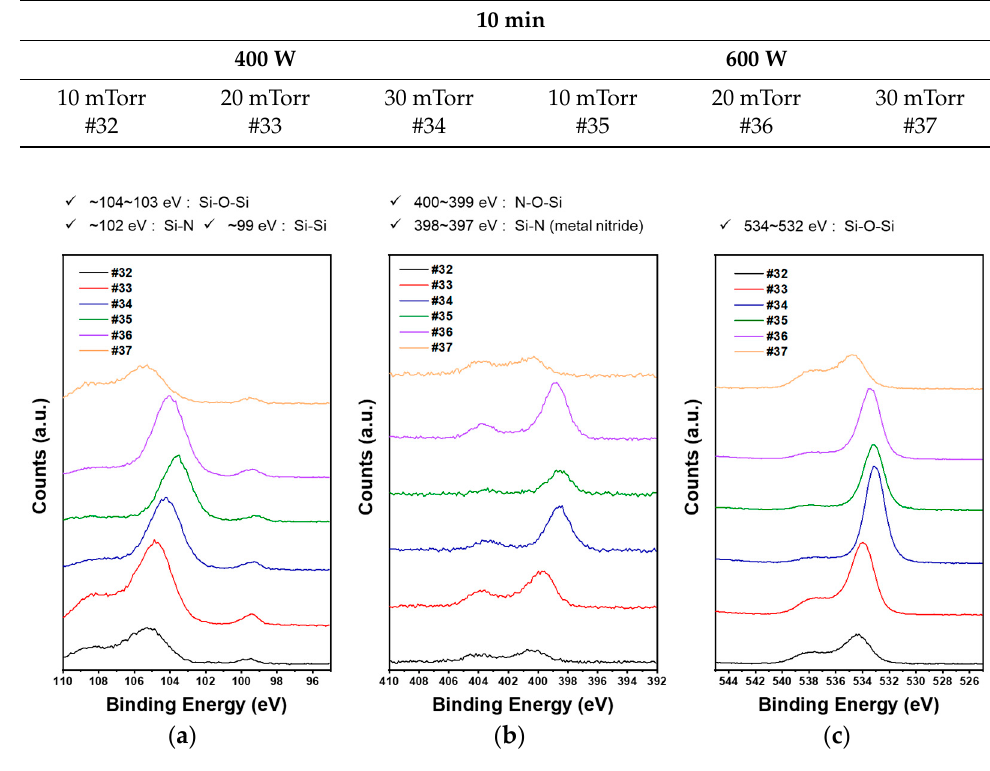
Figure 5. XPS spectra of the ( a ) Si 2p, ( b ) N 1s, ( c ) O 1s region of XPS spectra.